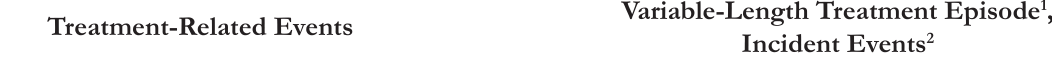
During the Variable-Length Post-treatment Period (N=141) Treatment-Related Events